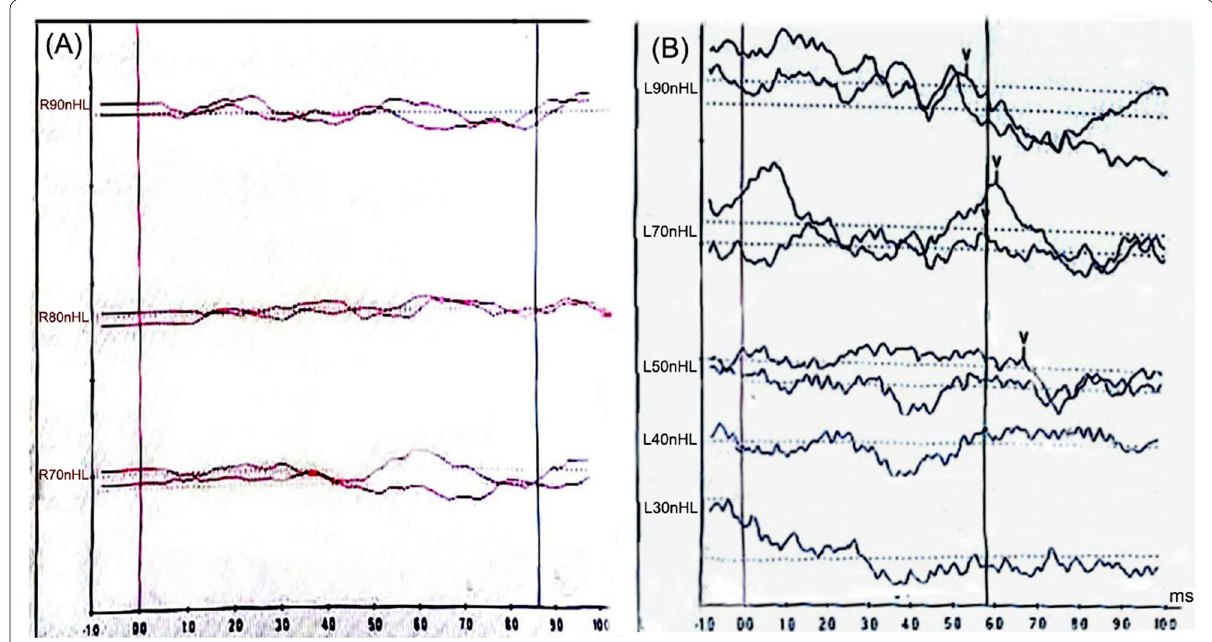
Fig. 2 Click evoked auditory brainstem response waveforms of the A left ear (in blue) and B right ear (in